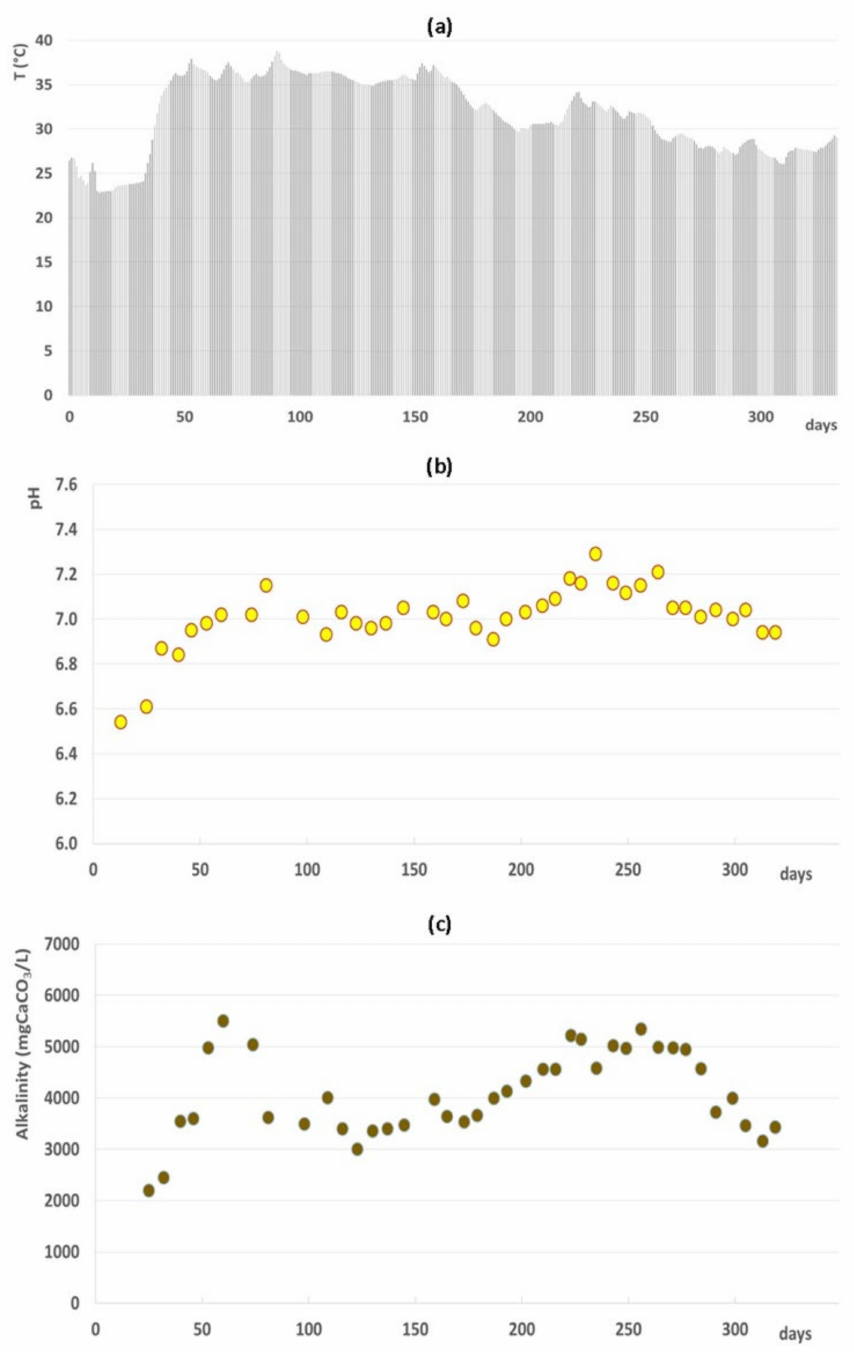
Figure 1. Trend of temperature ( a ), pH ( b ), and alkalinity ( c ) during the first year of operation of the anaerobic